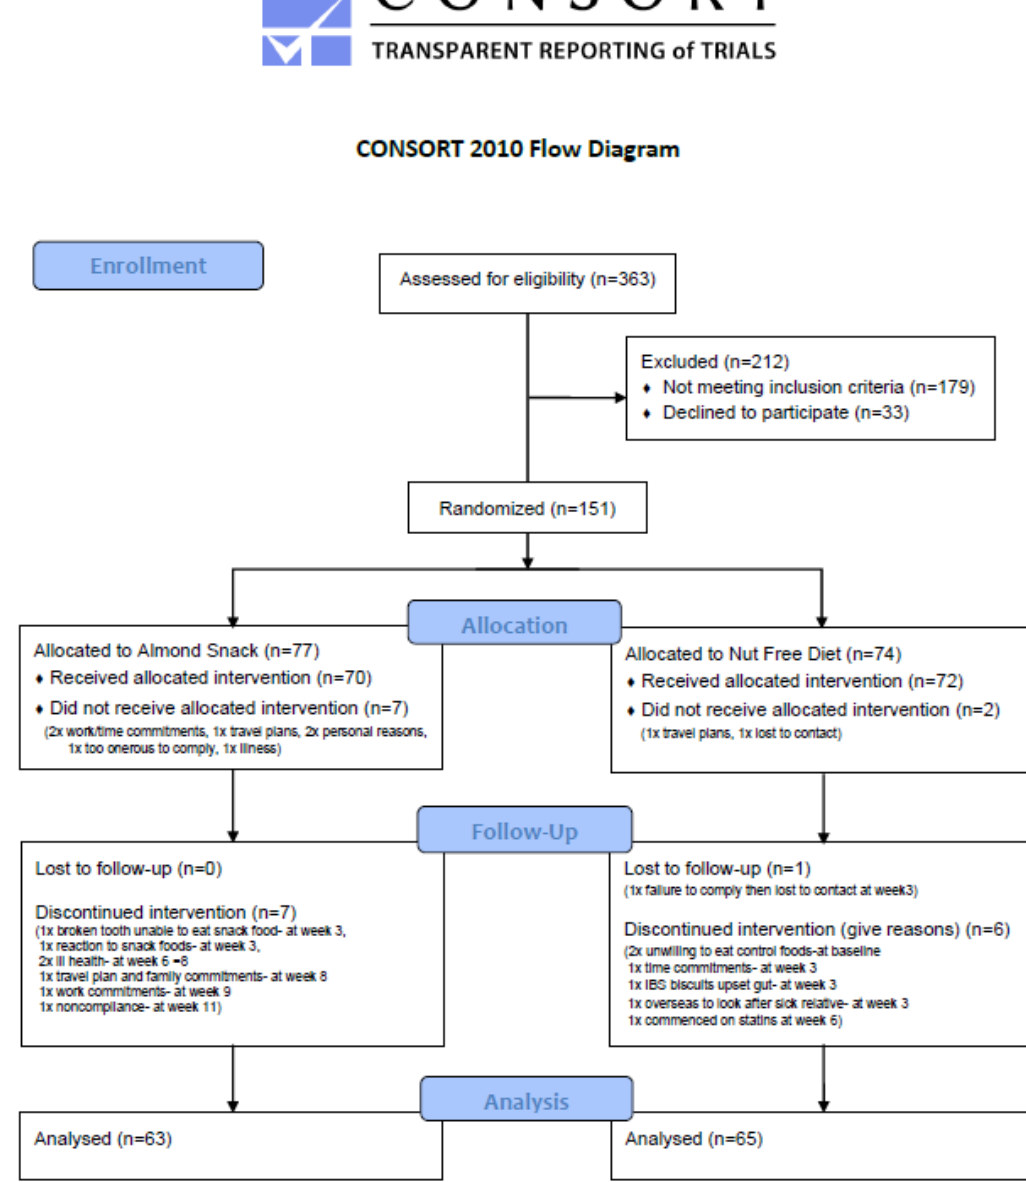
Figure 1. Consort diagram showing the flow of participants through the study.